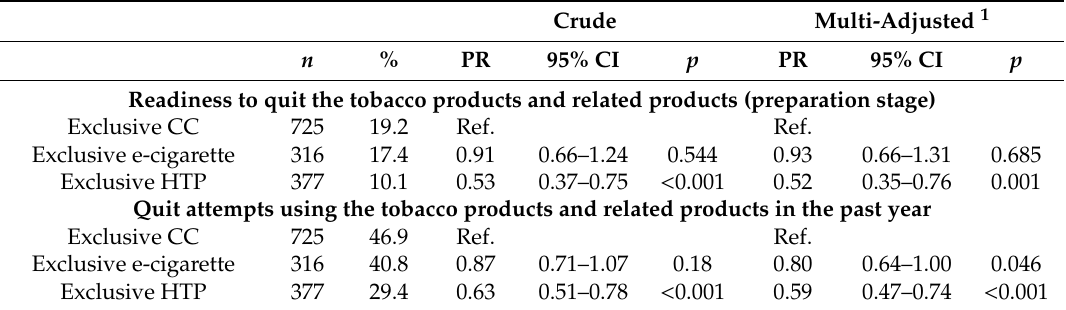
Table 4. Multivariate association between exclusive use of tobacco products and related products and readiness to quit and quit attempts in the past year ( n = 1418).